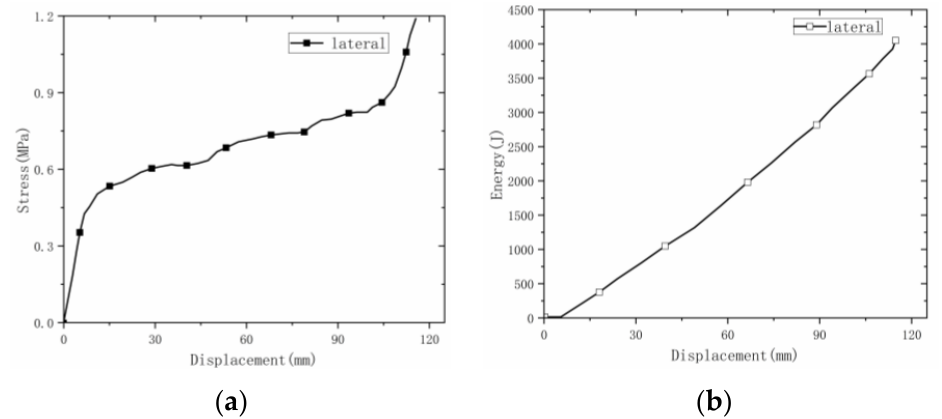
Figure 6. Schematic diagram of the axial compression process of origami honeycomb 3.